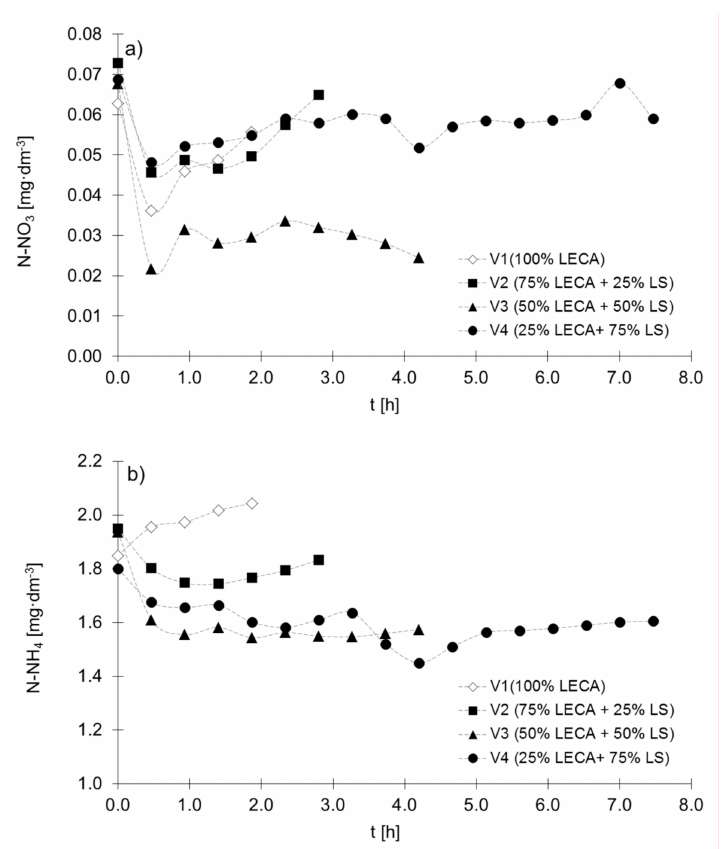
Figure 5. Concentrations of nitrates ( a ) and ammonium ( b ) in the hypolimnetic water during the treatments on column beds (LS: limestone); dashed lines were used for better visibility of the trend. Results were presented for the time of effective sorption (OP removal rate of ≥ 10 ±